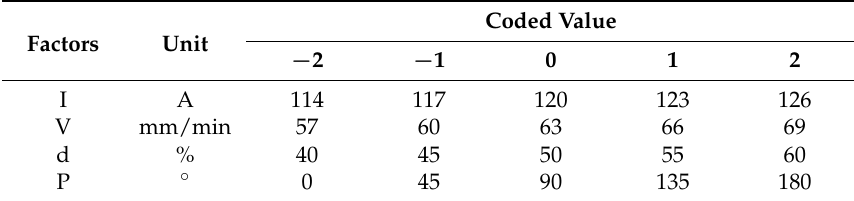
Table 2. Important weld parameters and their levels for copper–nickel alloy pipe.